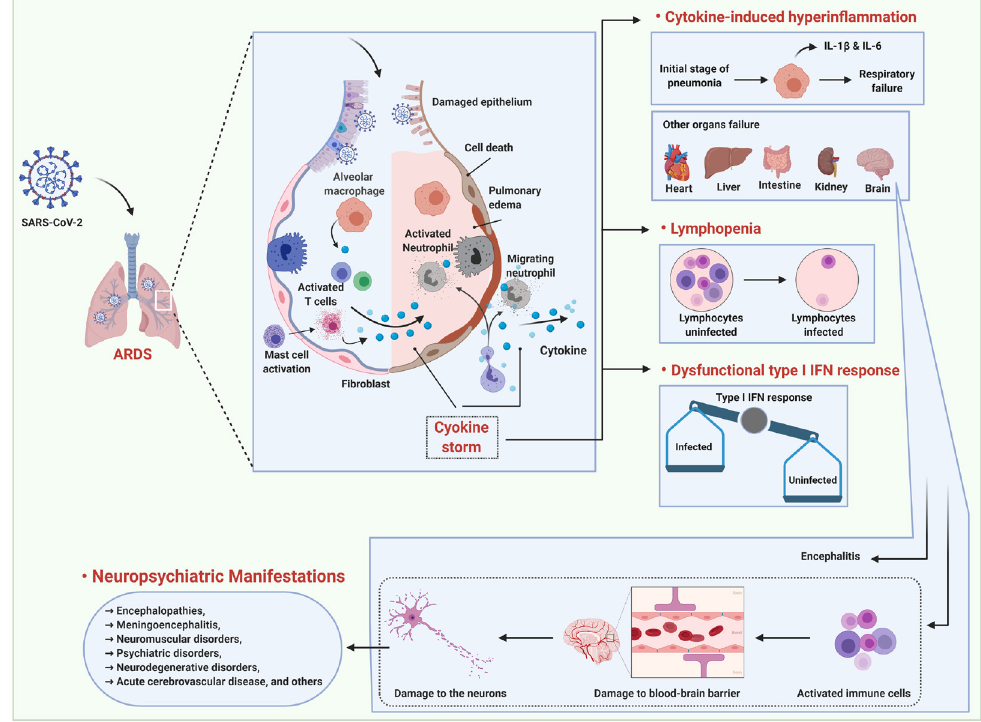
Figure 1. Schema showing the lung pathology caused by infection with SARS-CoV-2 during ARDS, cytokine-induced hyperinflammation. ARDS is a form of severe hypoxemic respiratory failure, which is mainly characterized by inflammatory injury to the alveolar capillary barrier with extravasation of protein-rich oedema fluid into the airspaces [14]. How ARDS leads to a cascade of events is shown in this schema. In severe infection, the SARS-CoV-2 is a systemic illness, which is typified